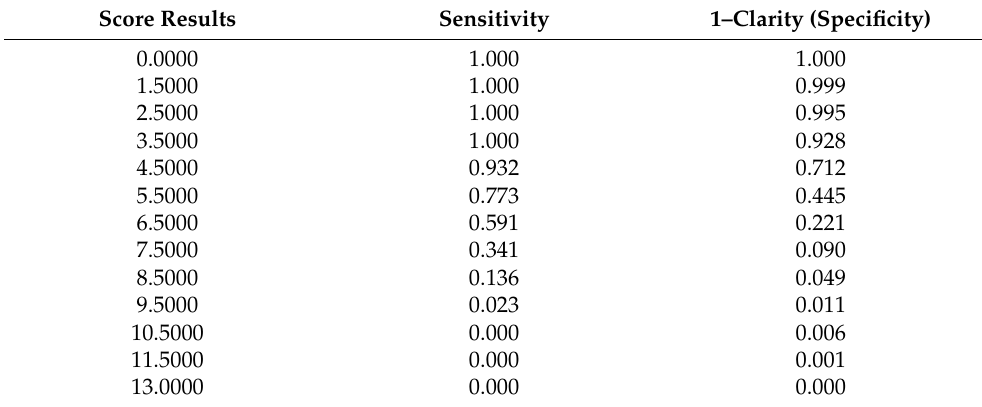
Table 2. ROC analysis of psychiatric